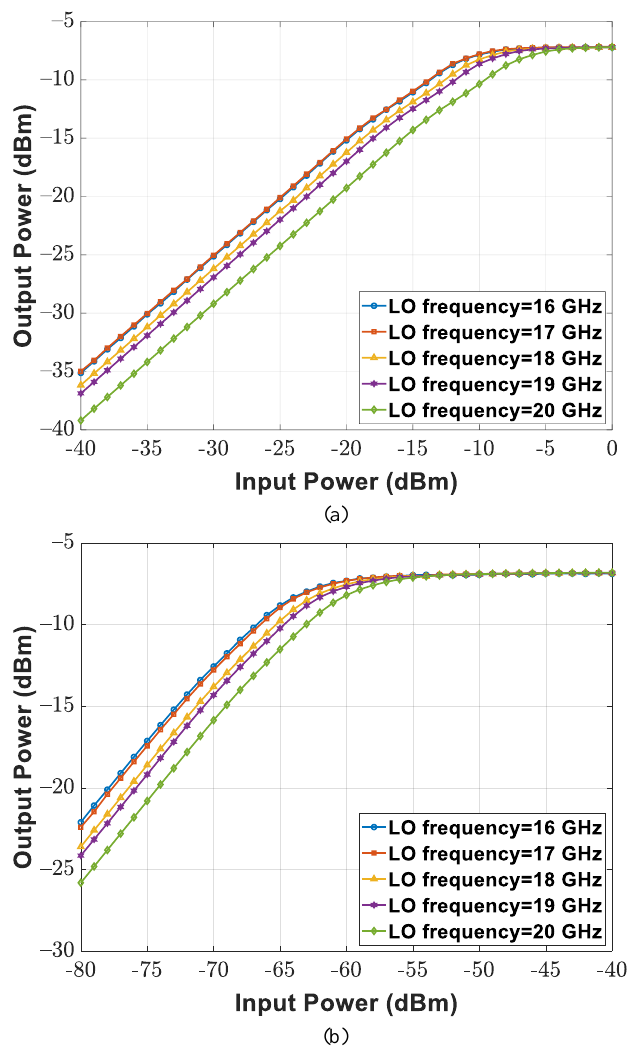
Figure 23. The 1 dB compression point ( P 1 dB ) of the implemented receiver for ( a ) lowest conversion gain and ( b ) highest conversion